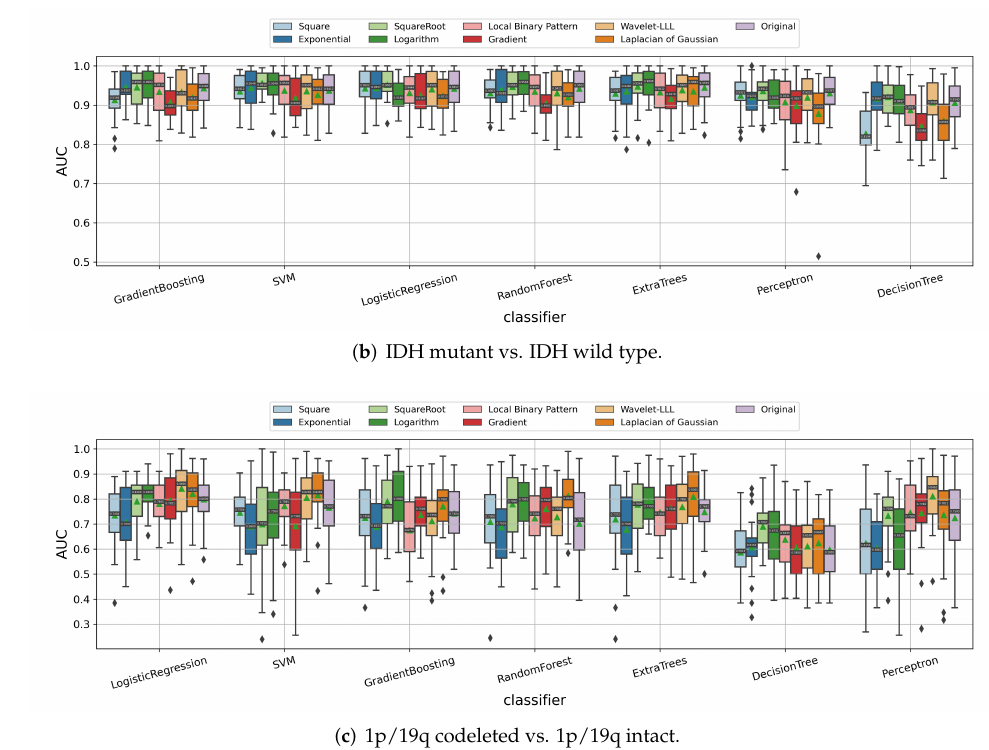
Figure 5. Impact of different image filters for predicting ( a ) tumor grade, ( b ) IDH mutation sta- tus, and ( c ) 1p/19q codeletion status of the gliomas. Notably, the wavelet image filter has eight decompositions defined by using different high or low pass filters in each dimension. We chose to display “Wavelet-LLL” here because of its best performance compared to the other wavelet filters in our